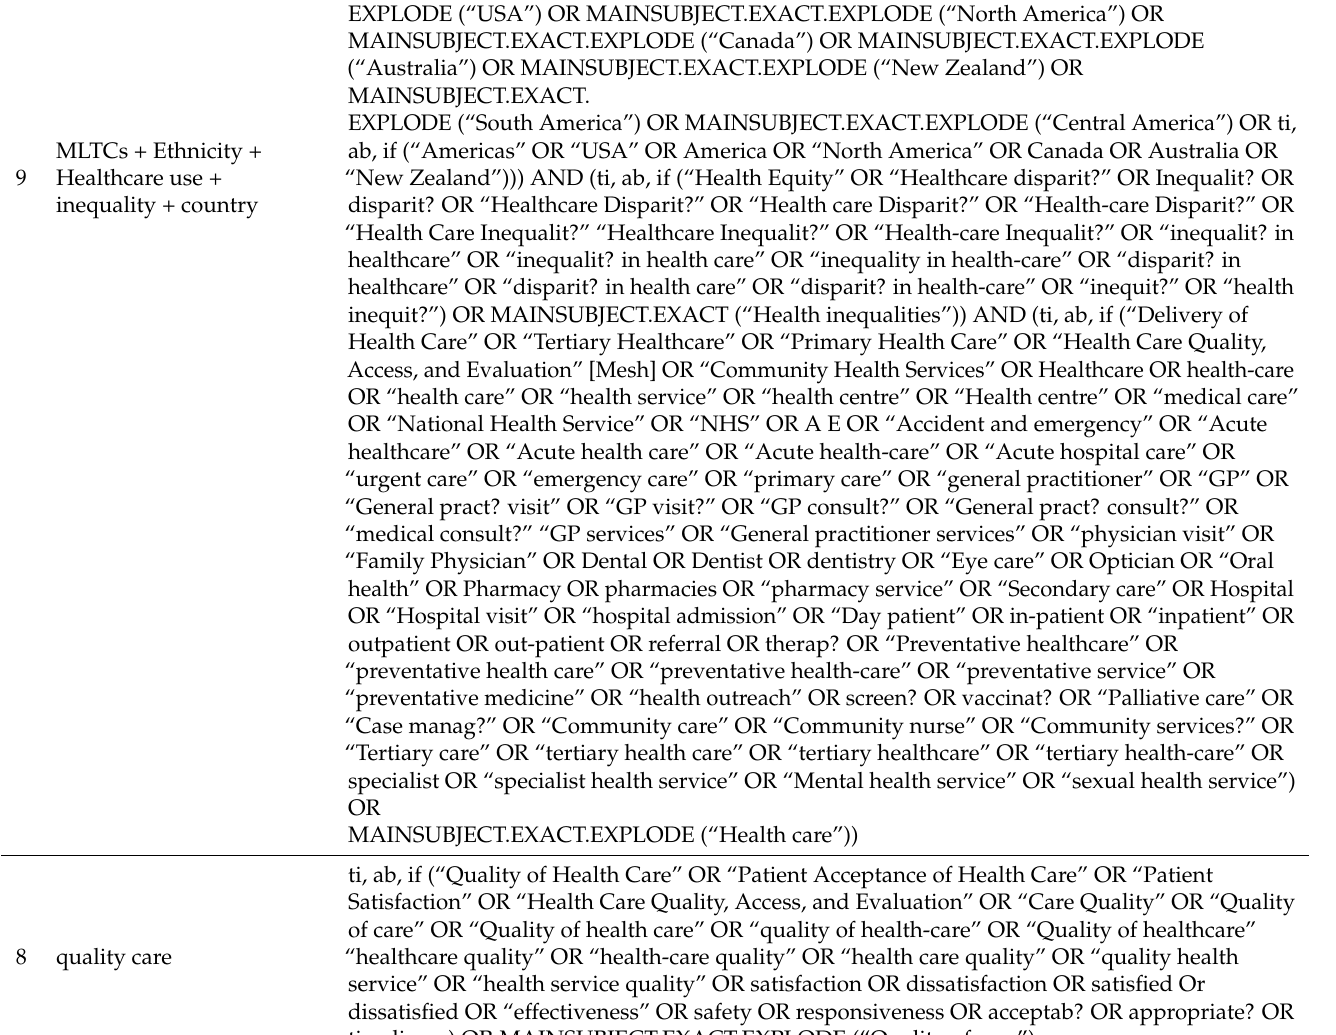
MLTCs + Ethnicity + 9 Healthcare use + inequality +